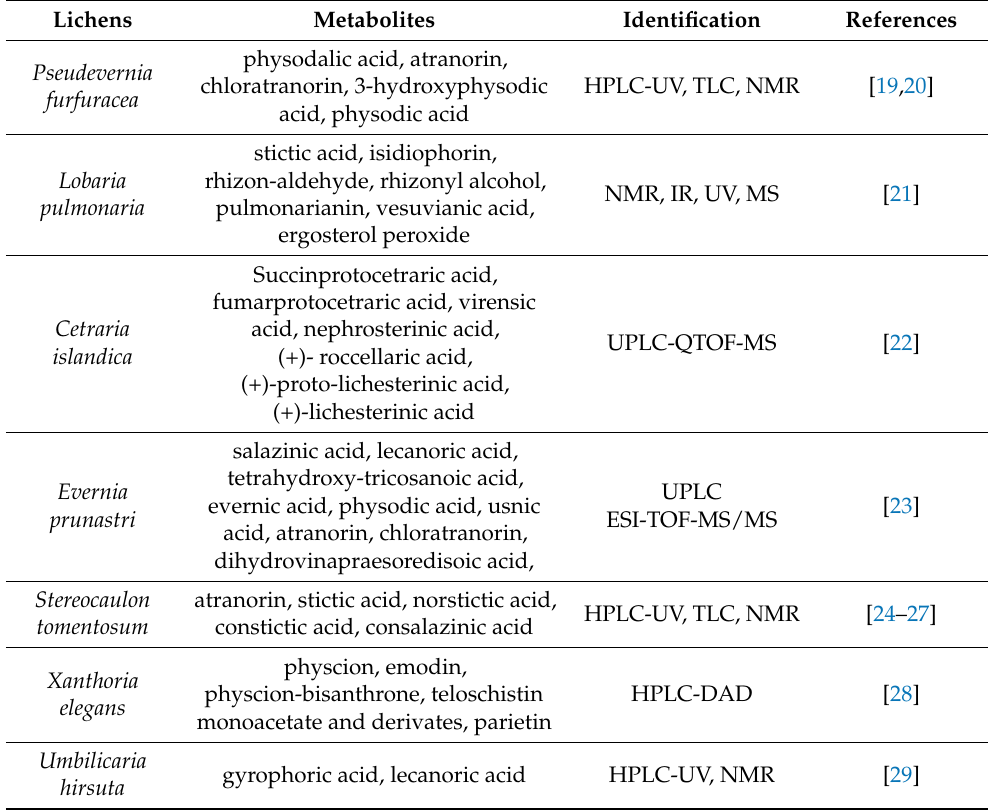
Table 1. Overview of Lichen extracts and their secondary metabolites with identification